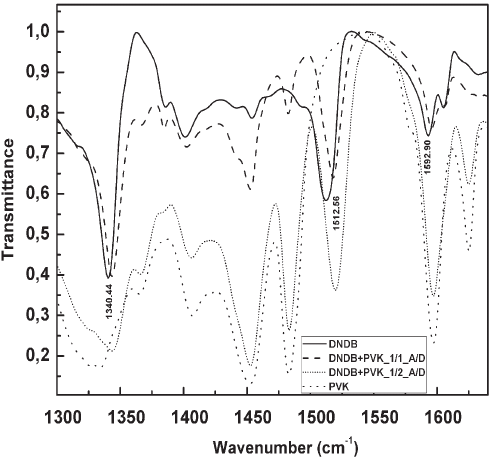
Figure 9. Expanded FTIR spectra for DNDB, PVK and PVK-DNDB